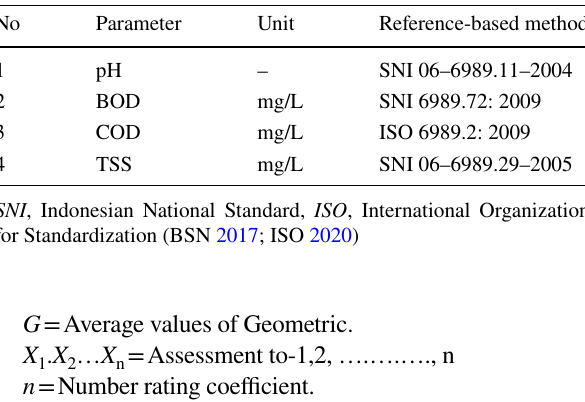
Table 1 Method for wastewater quality testing